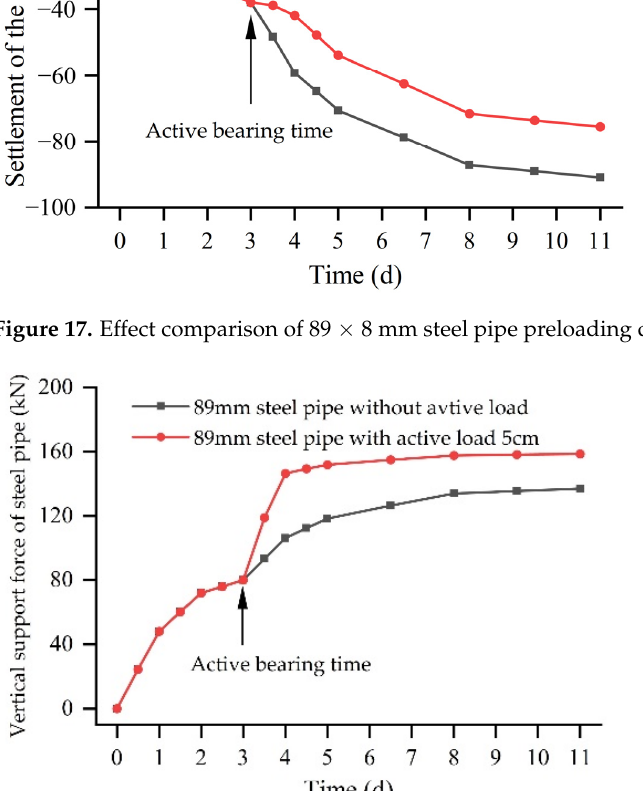
Figure 18. Stress comparison of 89 × 8 mm steel pipe preloading displacement of 50 mm.